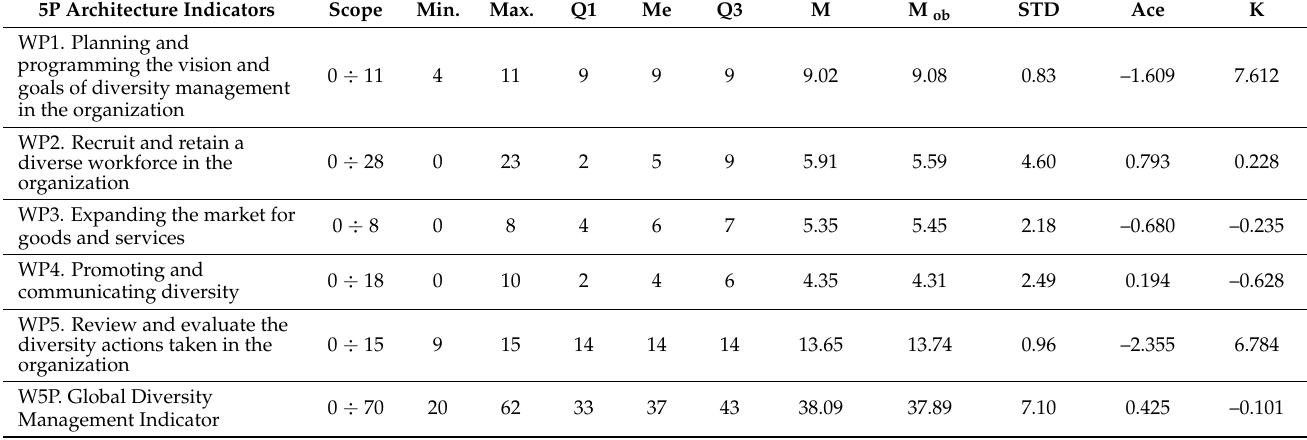
Table 2. Basic descriptive statistics of the 5P architecture